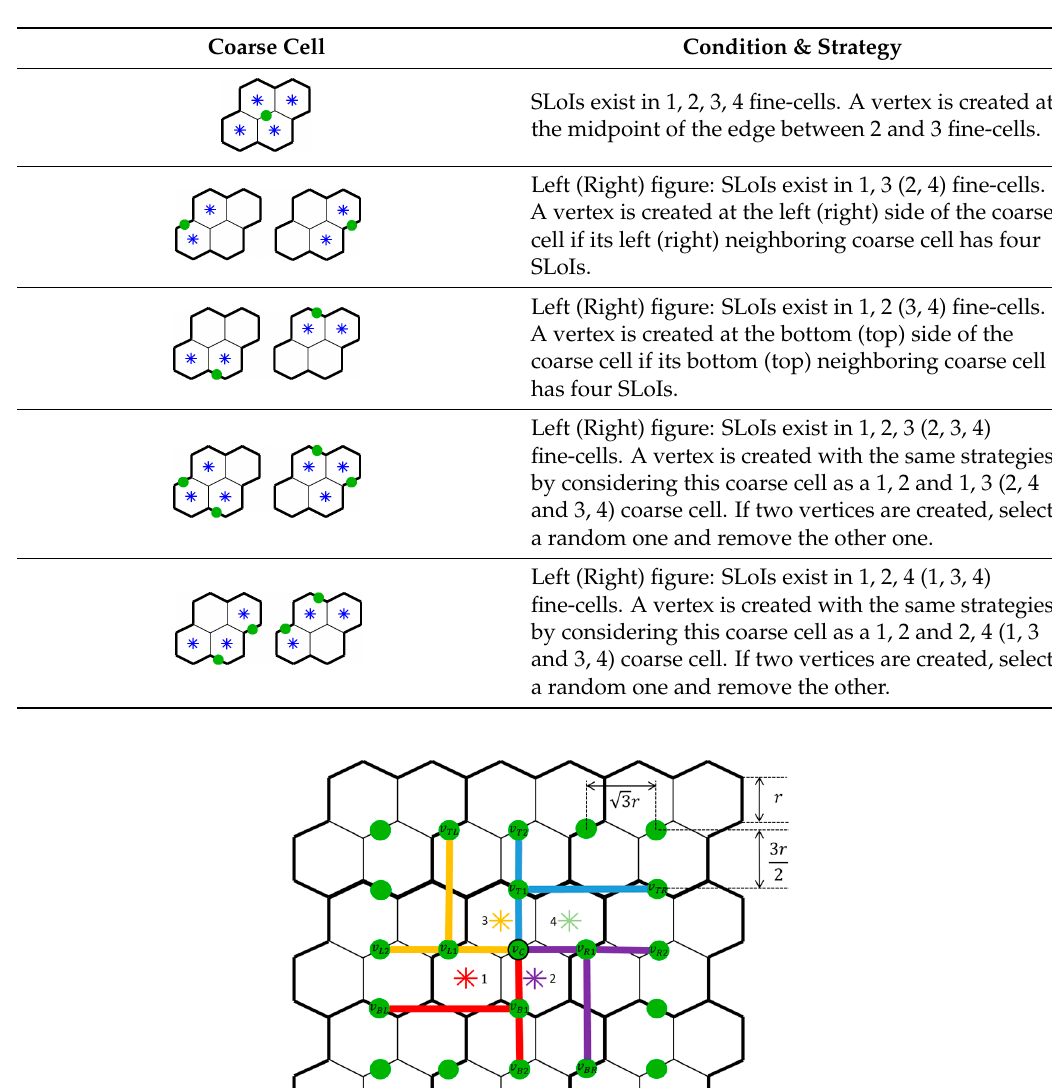
( d ) Figure 2. An execution example of the proposed hexagonal grid-based survey planner: ( a ) Hexagonal tessellation with Sampling Locations of Interest (SLoIs); ( b ) The created Minimum Spanning Tree (MST) vertices and the constructed relative MST; ( c ) Generation of the circumnavigation path based on the MST. The solid circle on the path denotes a selected starting point; ( d ) The overall path ring after path update. 3.2. Spanning Tree-Based Path Planning The SLoIs are generated following the sampling frame introduced above. To measure these points, in this work, a spanning tree-based path planning approach is proposed for sensor scheduling and path planning. This approach has been originally implemented on a coverage path planning problem using square cellular decomposition [30–32]. In this paper, a novel spanning tree-based survey planner is proposed with hexagonal cellular decomposition. First, a Minimum Spanning Tree (MST) is constructed (cid:1846) (cid:3040)(cid:3036)(cid:3041) = ((cid:1848) (cid:3021) , (cid:1831) (cid:3021) ) , where (cid:1848) (cid:3021) and (cid:1831) (cid:3021) are the sets of vertices and edges of the tree, respectively. Then, a path to visit all sampling locations is generated based on the obtained MST.